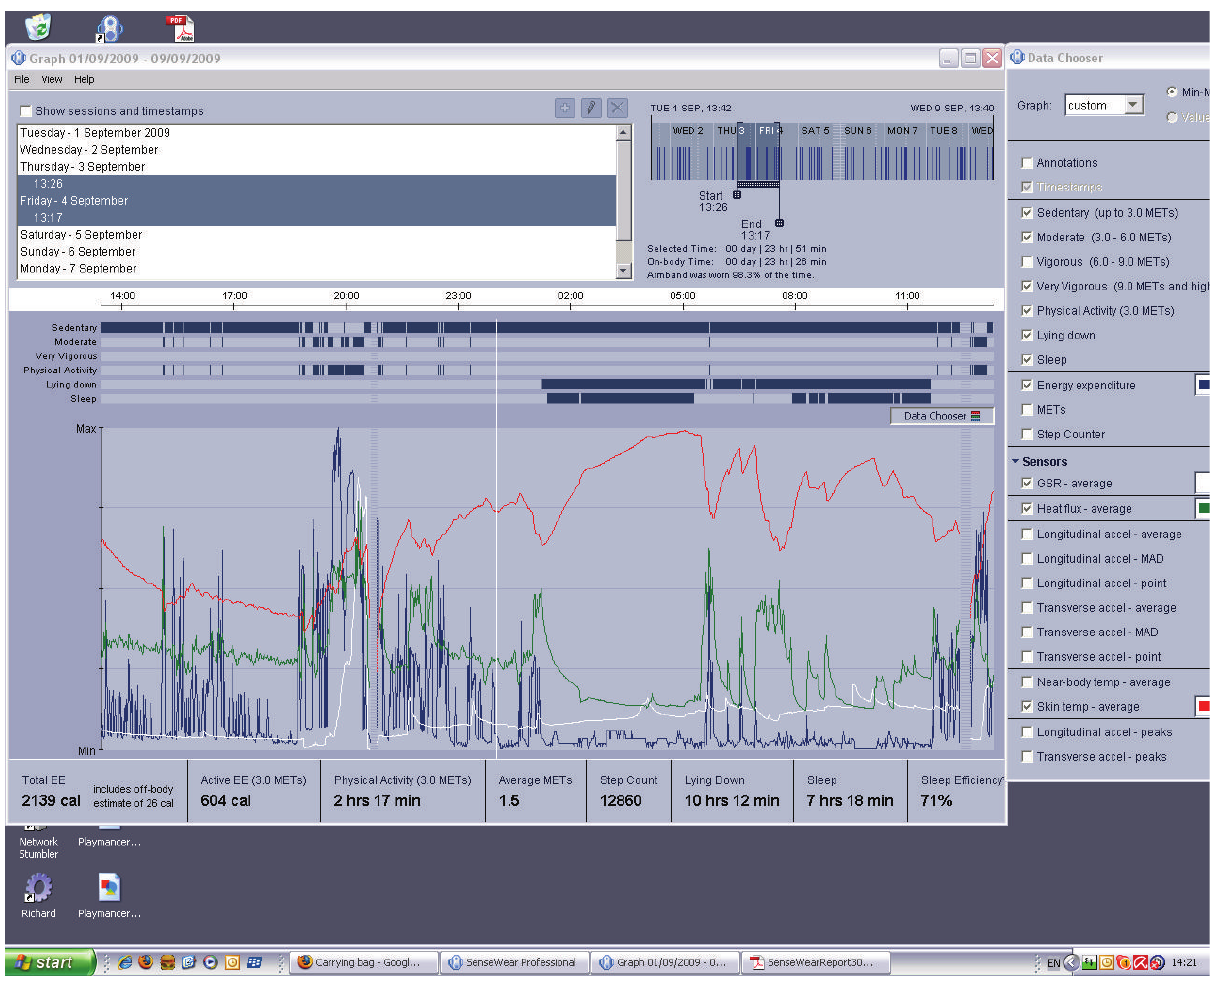
Figure 8: Pattern over 1 day (note the workout at the gym around